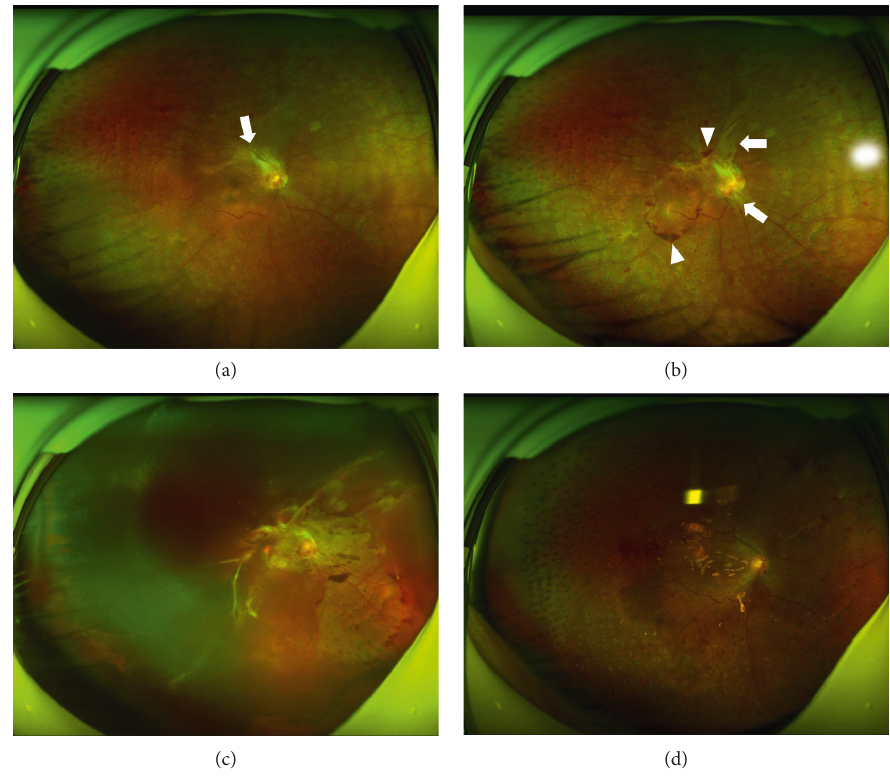
Figure 2: Representative case of progressive proliferation in the fellow eye. Mild proliferation (arrow) appeared in the superior vascular arch before intravitreal conbercept injection in the contralateral eye (a). However, progressive proliferation (arrows) and hemorrhage (ar- rowheads) subsequently occurred 4weeks thereafter (b). Tractional retinal detachment and vitreous hemorrhage were diagnosed 9weeks later (c). Although the retina was reattached after vitrectomy in the fellow eye, visual outcome was poor (d).